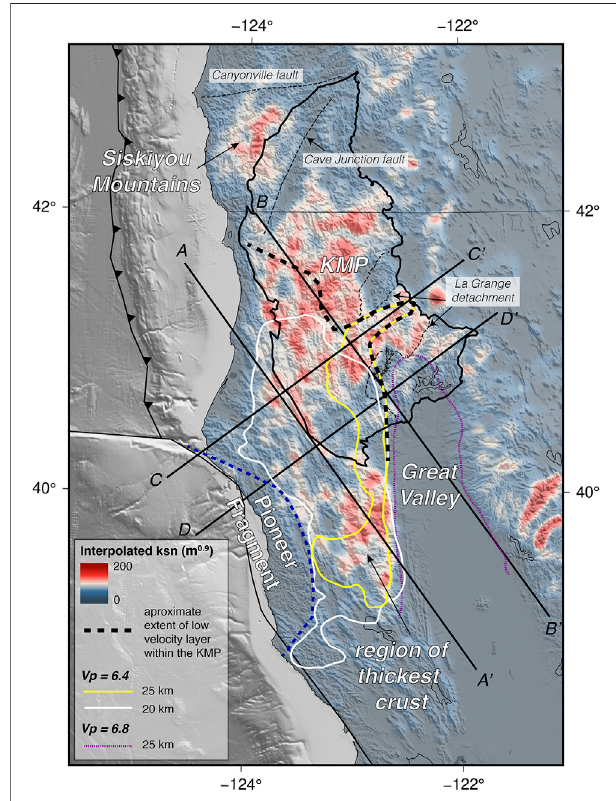
FIGURE 10 | Interpolated channel steepness ( k sn ) for the region of southern Cascadia. The blue dashed line shows the extent of the Pioneer fragment from the tomography results. The black dashed lines shows the approximate extend oflowvelocity(Franciscan) material withinthe KMP, derived from the tomography results. The white and yellow solid lines are the 6.4 km/s p-wave velocity contours from the tomography imagery at 20 and 25 km depth respectively, that we interpret represent the extent of the thickened Franciscan crust at those depths. The purple dashed line is the 25 km depth of the 6.8 km/s p-wave velocity contour, that we interpret to outline the Great Valley ultrama fi c body at that